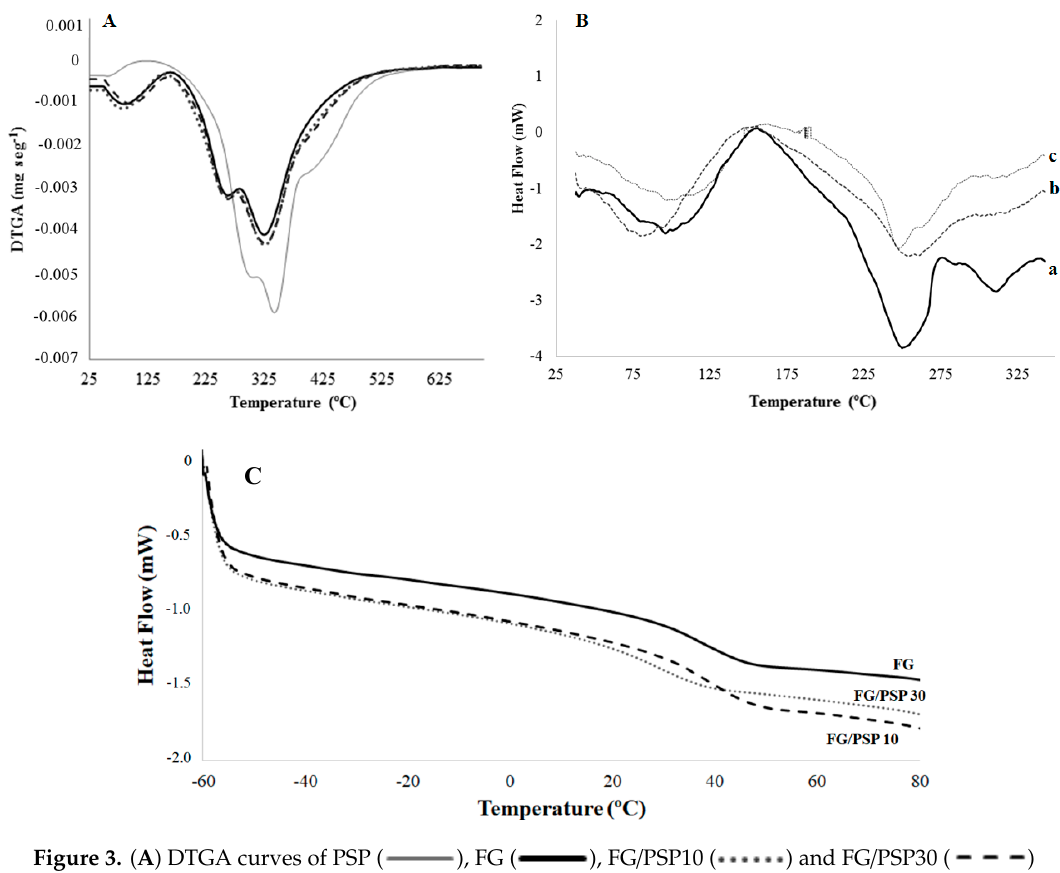
Figure 3. ( A ) . DTGA curves of PSP ( ), FG ( ), FG/PSP10 ( ) and FG/PSP30 ( ) films. ( B ) . DSC thermograms of FG ( a ), FG/PSP10 ( b ) and FG/PSP30 ( c ) films. ( C ). T g values obtained from the second scan of DSC curves for FG, FG/PSP10 and FG/PSP30 films. Table 4. Thermal parameters obtained for bio-composite films ( n = 3, mean ± SD).